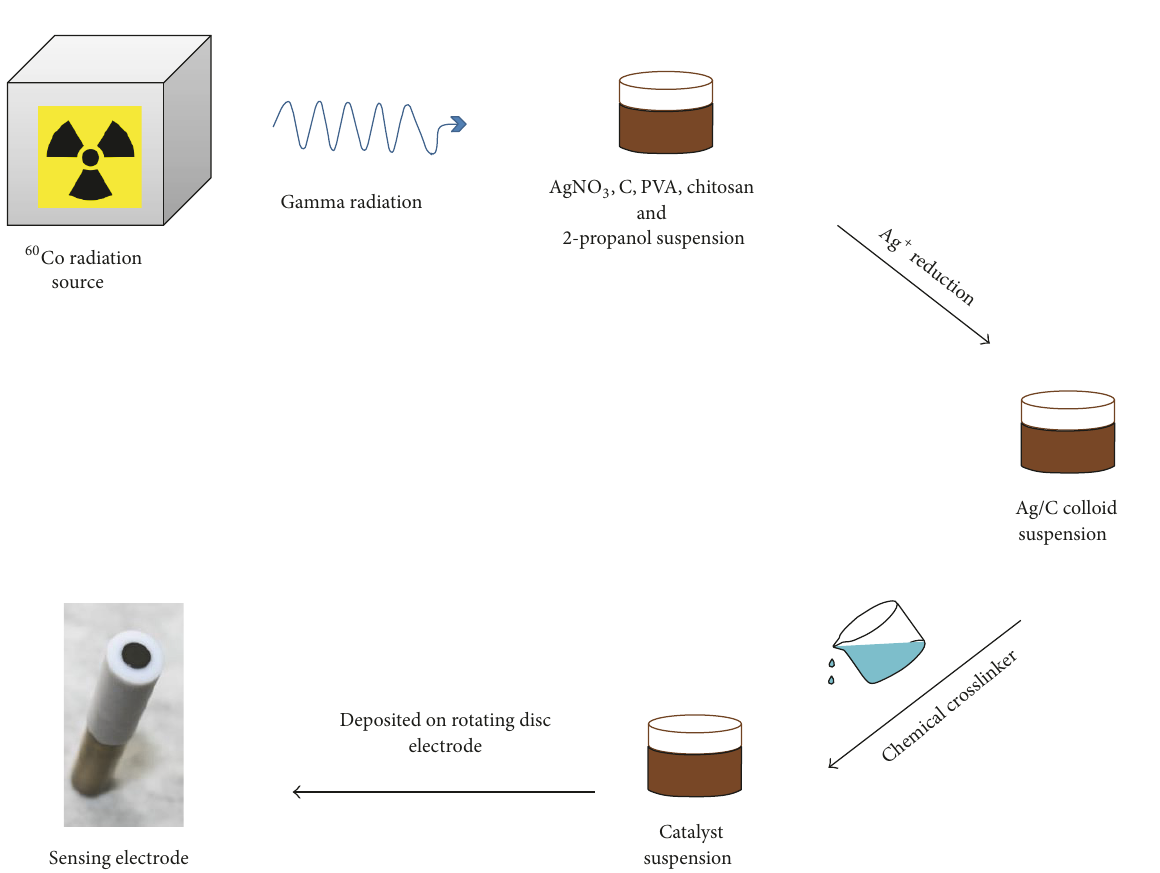
Figure 2: Schematic representation of catalysts and working electrodes preparation procedure.